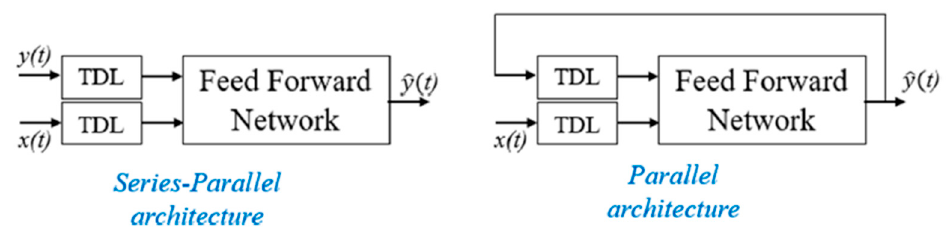
Figure 6. Architectures of the NARX neural network.